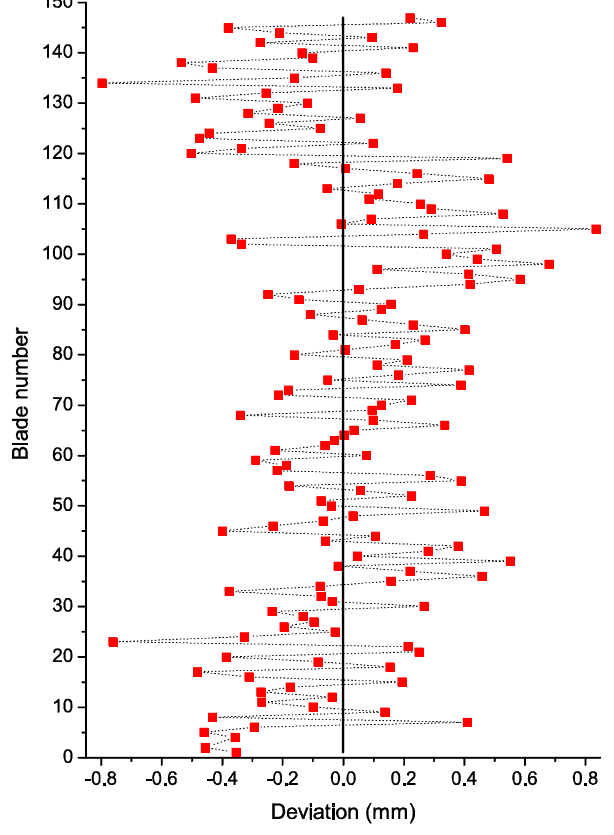
Figure 8. Deviation of each blade from the equilibrium position in a complete